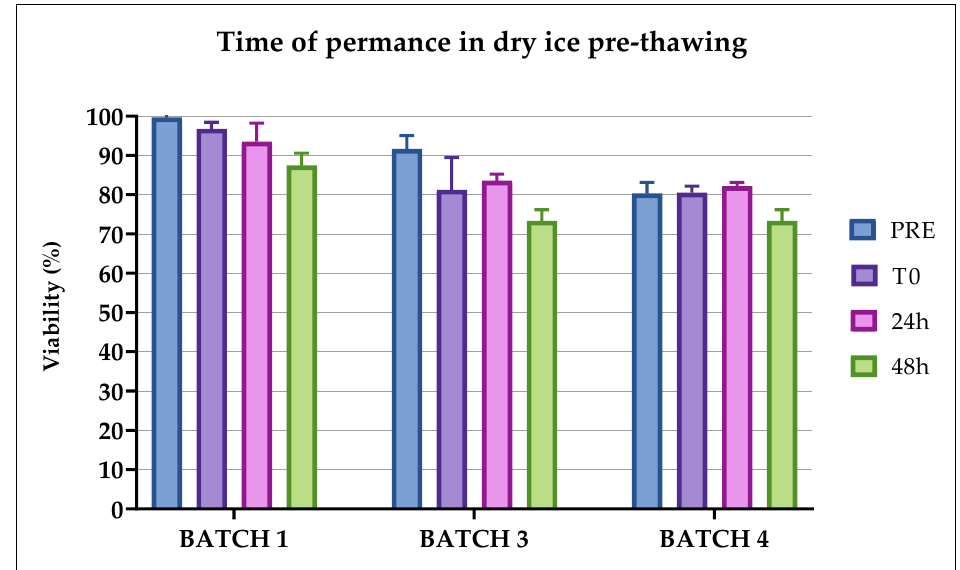
Figure 3. Viability on Batches 1, 3 and 4 evaluated for the validation of the cryopreservation and transportation processes before thawing. The percentage of viable cells was calculated for the CIK cells immediately after thawing, and then after 24 h and 48 h on dry ice, to validate the time for which CIK cells are stable prior to thawing.